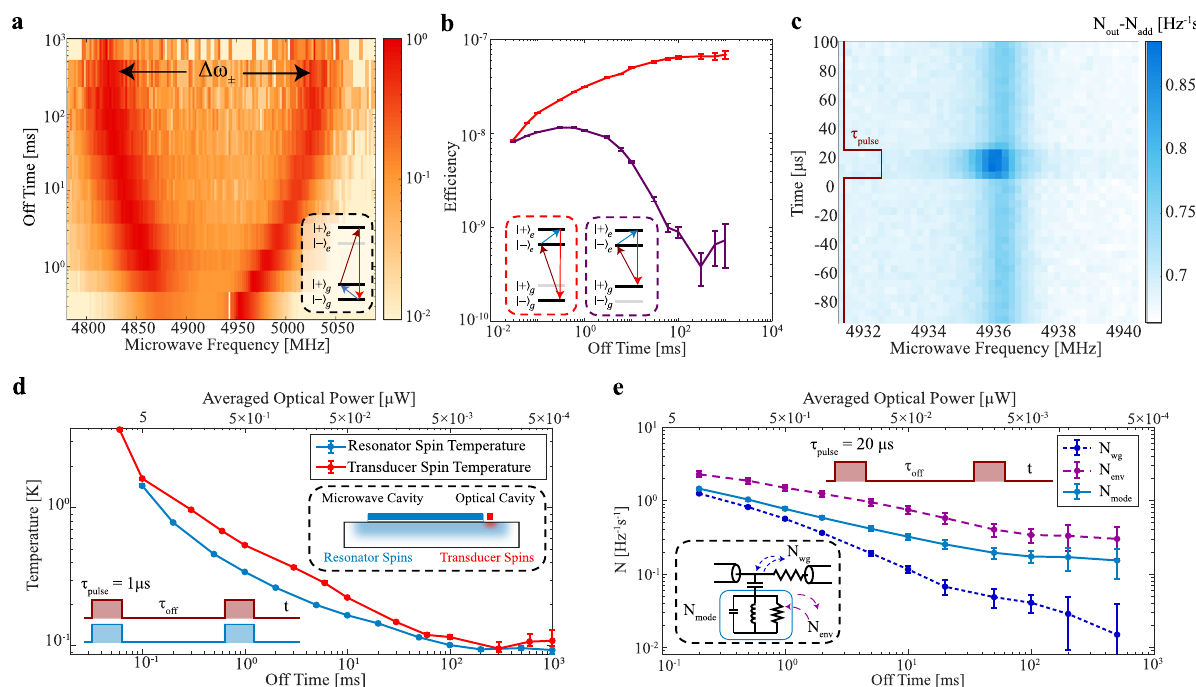
Fig. 4 | Transducer Temperature Characterization. a Pulsed ground state trans- ductionspectrumfordifferentofftimesbetweenadjacent1 µ stransductionpulses to characterize the temperature of the ground state spins coupled to the micro- wave resonator. The frequency splitting in the transduction signal ( Δ ω ± ) matches the microwave resonator mode splitting and indicates the ground state spin populationdistribution. b Pulsedexcitedstatetransductionef fi ciencyforcoupling to both ground state levels (lower ground state level in red and the higher ground state level in purple) as a function of the off time ( τ off ) between adjacent 1 µ s transduction pulses. The ef fi ciency ratio corresponds to the temperature of the ground state spins within our transducer. c Time-resolved microwave resonator noise spectrum for an optical pulse sequence with P o =550 µ W, τ pulse =20 µ s and τ off =5ms. The noise spectrum includes contributions from the microwave